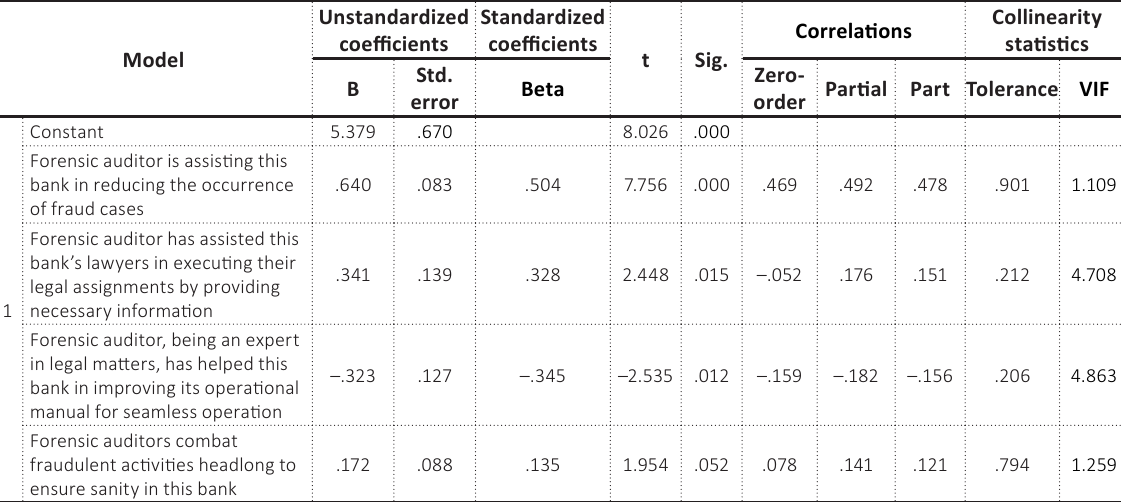
Table 9. Coefficients